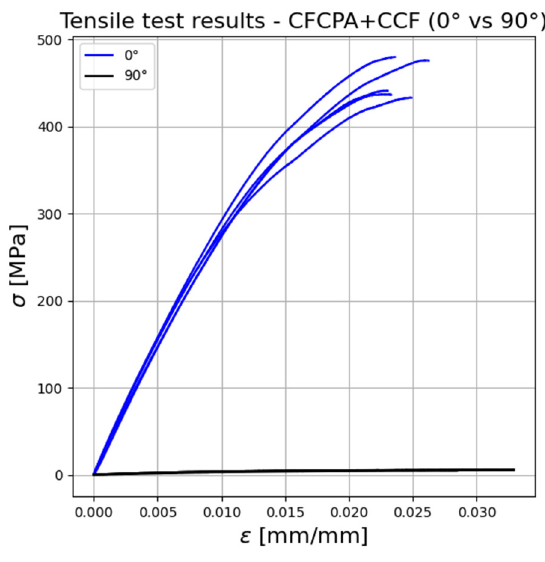
Figure 12. Stress–strain relationship of continuous FRP with different deposition patterns.